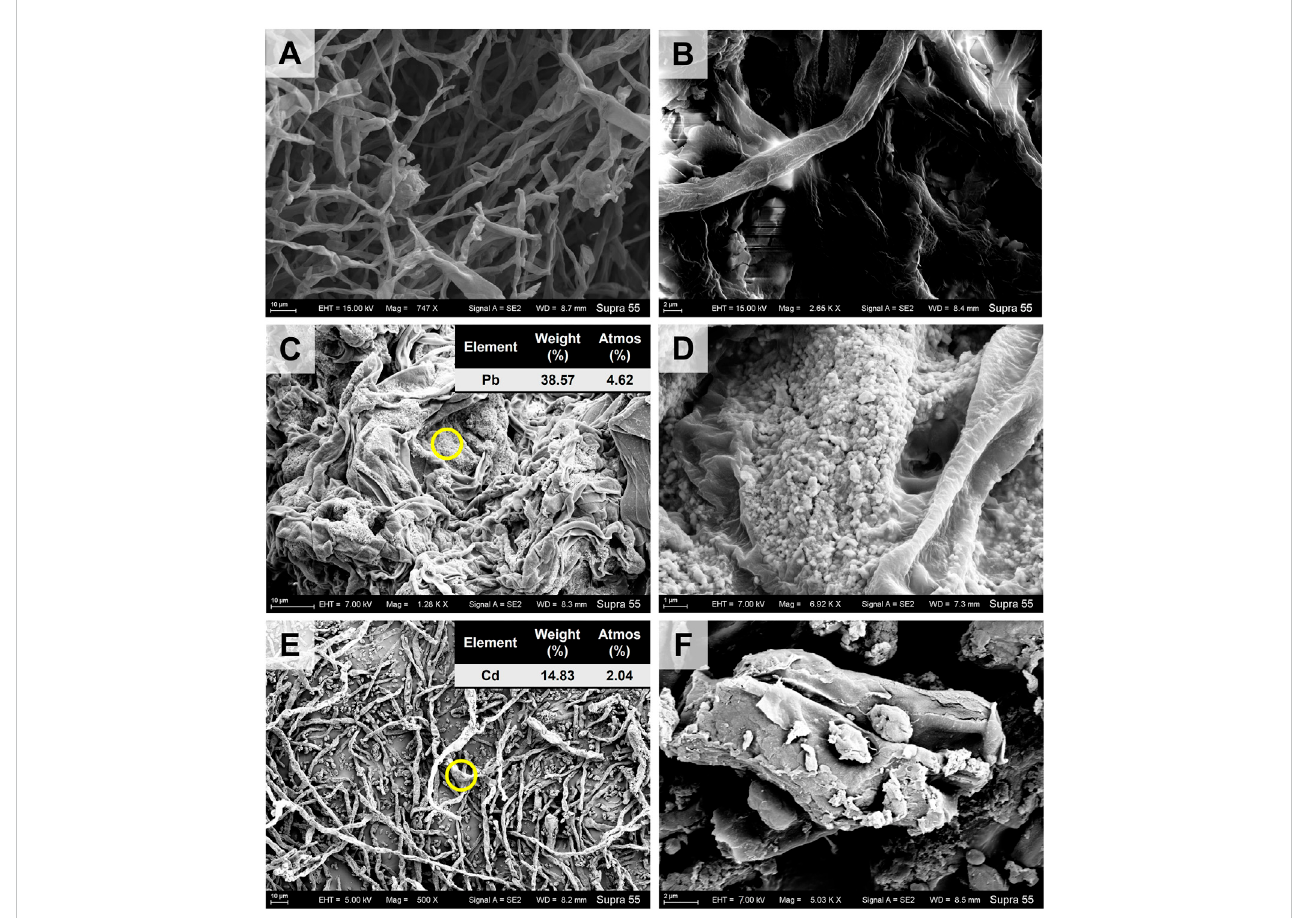
FIGURE 1 The SEM images of Aspergillus niger after 5 days incubation in the CK (A, B) , TPb (C, D) , and TCd (E, F) treatments. The representative particles on the mycelial surface in images C and E were selected for EDS analysis.